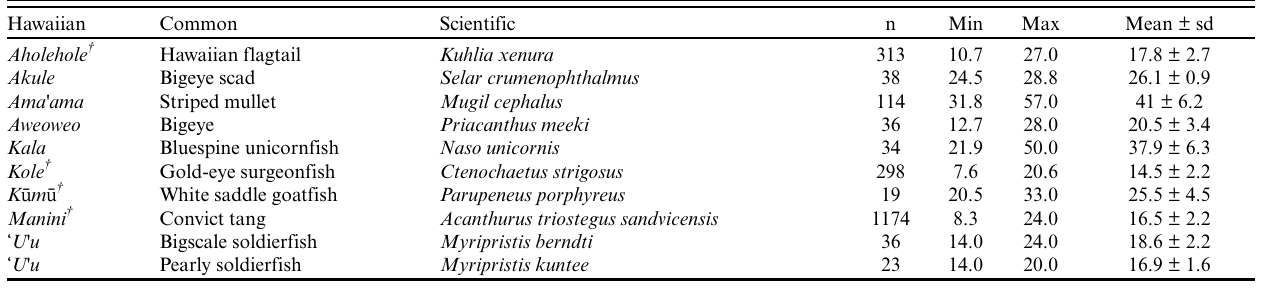
Table 1 . The Hawaiian, common, and scientific names of the top 10 monitored species along with the corresponding sample size, size range, and mean size (fork length). † = endemic species or